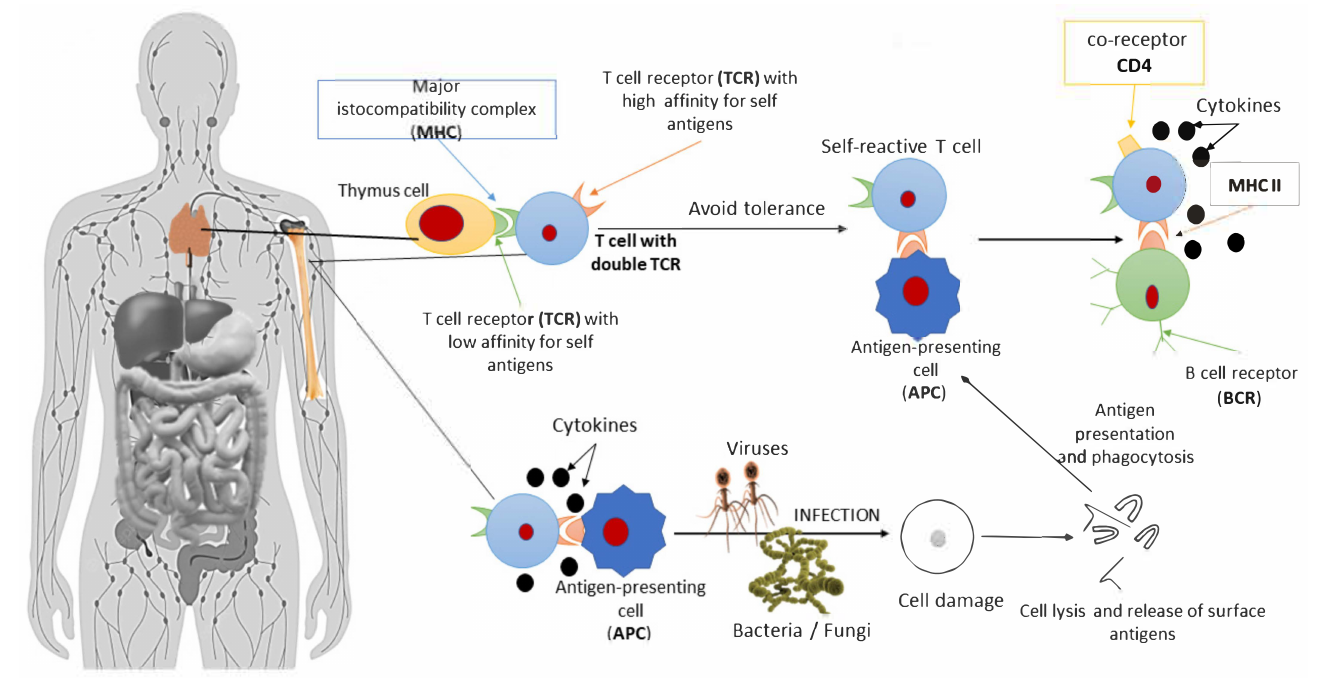
Figure 3. The proposed mechanism of immune system avoidance through tolerance due to the phenomenon of molecular mimicry. T cells with different α and β chain arrangements and dual TCR receptors bind either microbial and self-antigens (presented by antigen-presenting cells), leading to the production of cytokines and autoantibodies [73]. There are four types of molecular mimicry: (a) Absolute identification of the protein presented by the host; (b) homology at the protein level; (c) common sequences of amino acids or epitopes between the host and the micro-organism or environmental factors; and (d) structural components of the micro-organism or environmental agent. Molecular mimicry, considering evolution, is another strategy by which organisms increase their chances of survival. The concept of molecular mimicry must include four criteria to be valid: (a) Similarity between an epitope of an organism and an epitope of a micro-organism or environmental factor; (b) patients with autoimmunity in whom a cross-reaction is observed; (c) epidemiological link with exposure to the respective environmental factor or micro-organism; and (d) reproducible autoimmunity in animal experimental models [73,99]. Credit: Original figure by I.A.